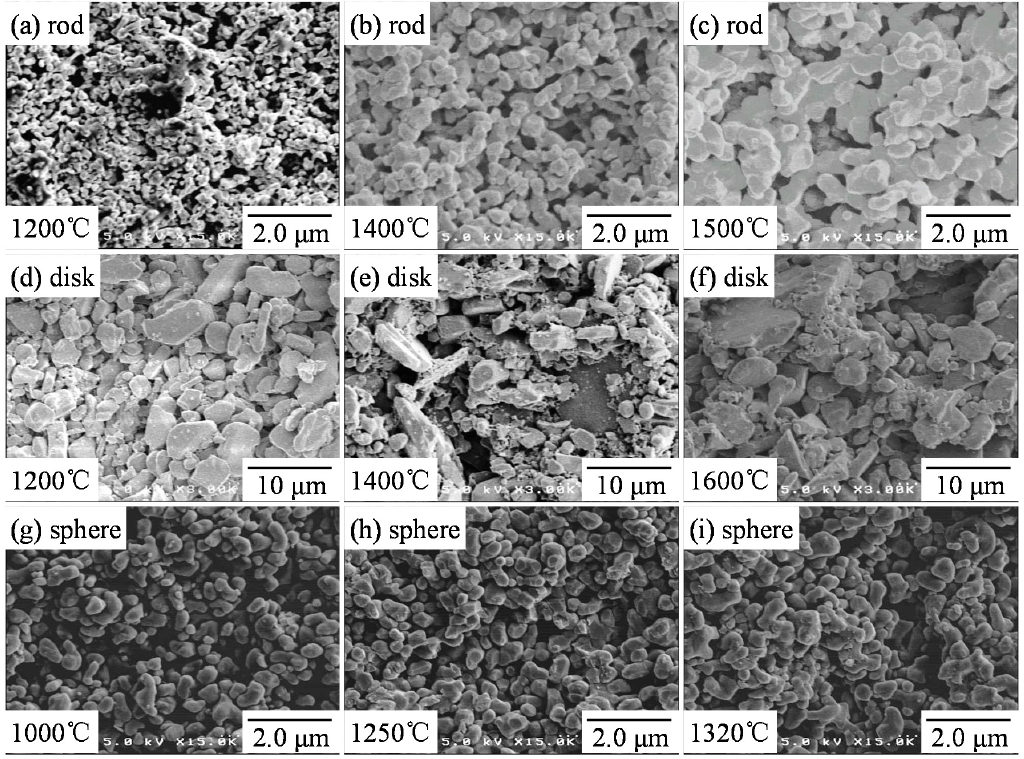
Figure 3. Microstructures of alumina compacts sintered from ( a – c ) rod-like particles, ( d – f ) disk-like particles, and ( g – i ) spherical particle at 1000–1600 °C.